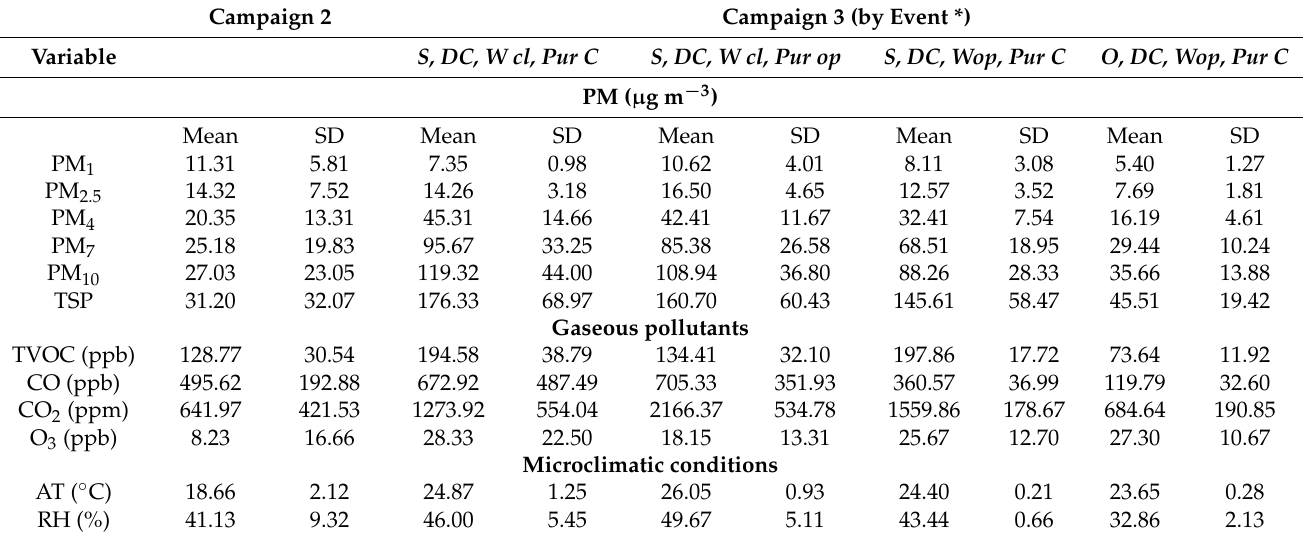
Table 3. Descriptive statistics of indoor and outdoor atmospheric pollutant concentrations along with air temperature and RH (Campaign 2 and 3).